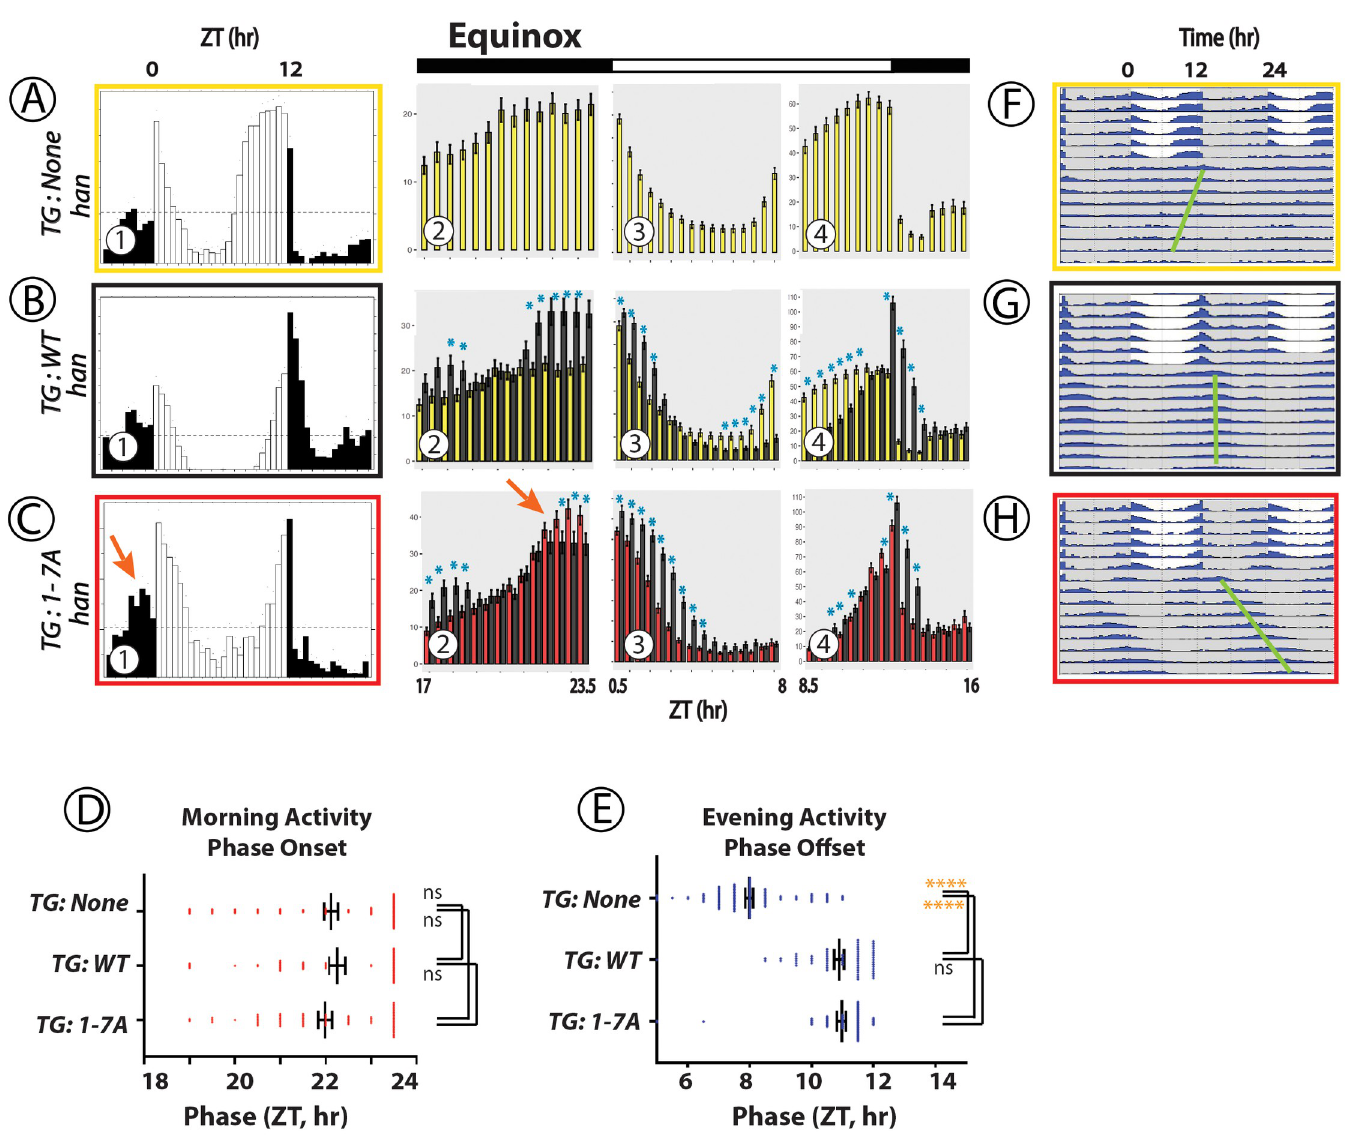
Fig 3. Locomotor Rhythms exhibited by pdfr mutant flies expressing the WT PDFR versus the 1-7A PDFR Variant under Equinox-like (12L:12D) conditions. All behavioral records were recorded from han ( pdfr mutant) flies that expressed either no UAS transgene (A, yellow box), or a UAS-WT pdfr transgene (B, black box) or a UAS-1-7A pdfr (C, red box)). The Panels display behavioral activity with a format similar to the one shown in Fig 2. Panels (A-(C) display average group eductions (6-day activity averages, with open bars indicating the 12-hr periods of Lights-on and filled bars the 12-hr periods of Lights-off) and bin-by-bin analyses to compare activity amplitudes between genotypes. TG : transgene. The red arrow indicates Morning activity in flies expressing the 1-7A variant with distinguished amplitude. Blue asterisks mark amplitudes that are significantly different between genotypes by ANOVA followed by a Students t-test (p < 0.05). Panels (D) and (E) display the phases of morning Onsets and Evening Offsets respectively. Gold asterisks: ANOVA followed by Dunnett’s post hoc multiple comparisons of all compared to WT: ns = not significant; � = p < 0.05; �� = p < 0.01; ��� = p < 0.005; ���� = p < 0.001. Panels (F)–(H) present double plotted actograms of group activity for each genotype over the ~6 days of light entrainment, followed by ~9 days of constant darkness (DD). The green bars indicate the phase of the dominant activity period in DD. The green bars indicate the phases of the dominant activity periods in DD.